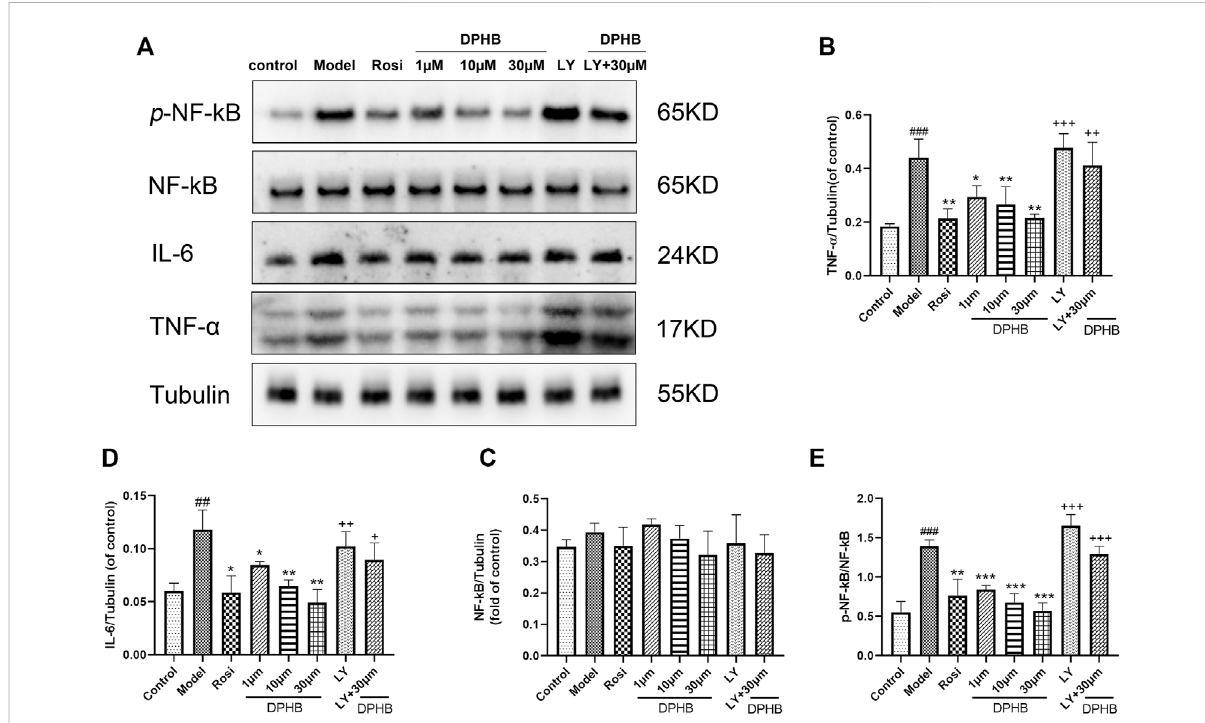
FIGURE 7 Effects ofDPHB ontheTNFsignaling pathway inIR-3T3-L1adipocytes. (A) Protein expression ofTNF- ɑ , IL-6, NF-kBp65, and p -NF-kBp65; (B) quanti fi cation of TNF- ɑ ; (C) quanti fi cation ofIL-6; (D) quanti fi cation of NF-kBp65; and (E) quanti fi cation of p -NF-kB p65.All valuesare expressed as means ± SD, ( n ≥ 3). * p < 0.05, ** p < 0.01, and *** p < 0.001, when compared with the model control group; ## p < 0.01 and ### p < 0.001, when compared with the control group; and + p < 0.05, ++ p < 0.01, and +++ p < 0.001, when compared with the 30- μ M DPHB